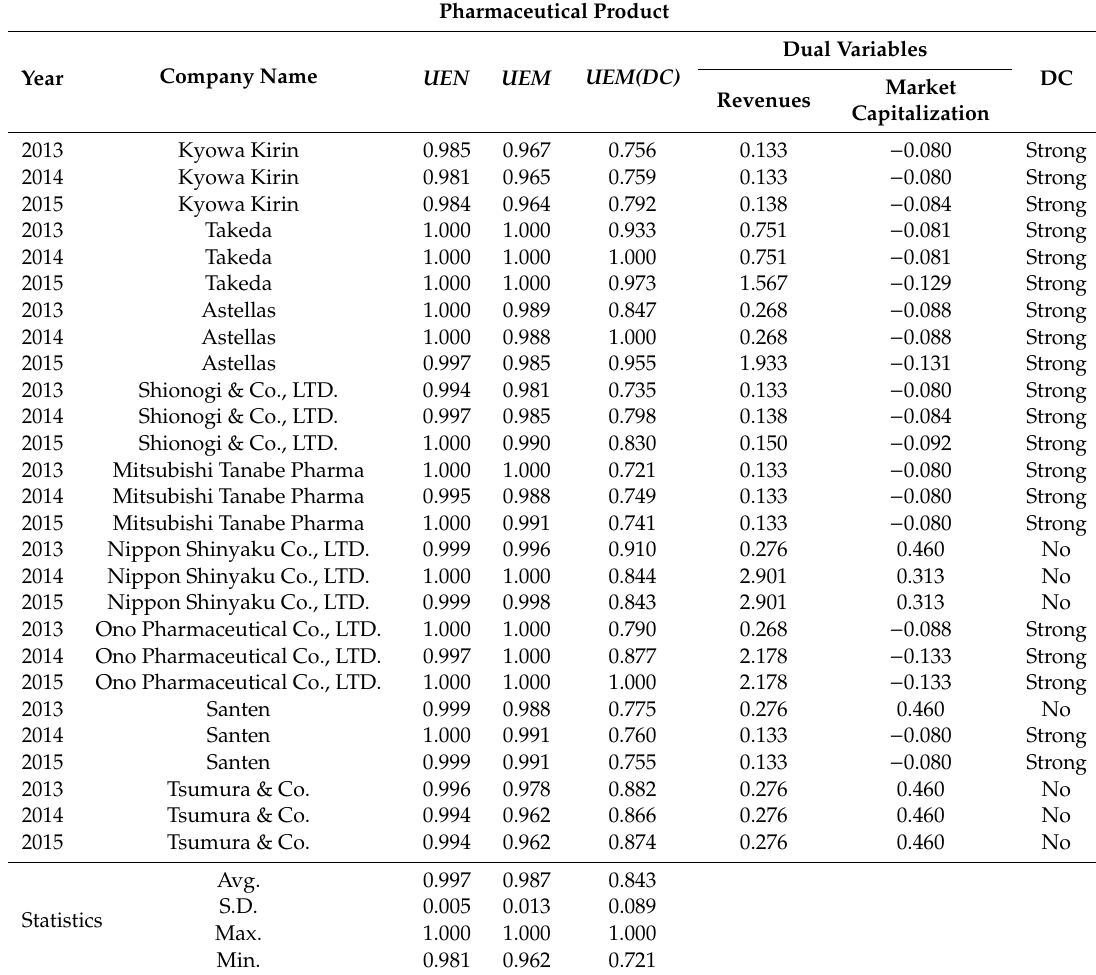
Table 2. Unified e ffi ciency measures on pharmaceutical product